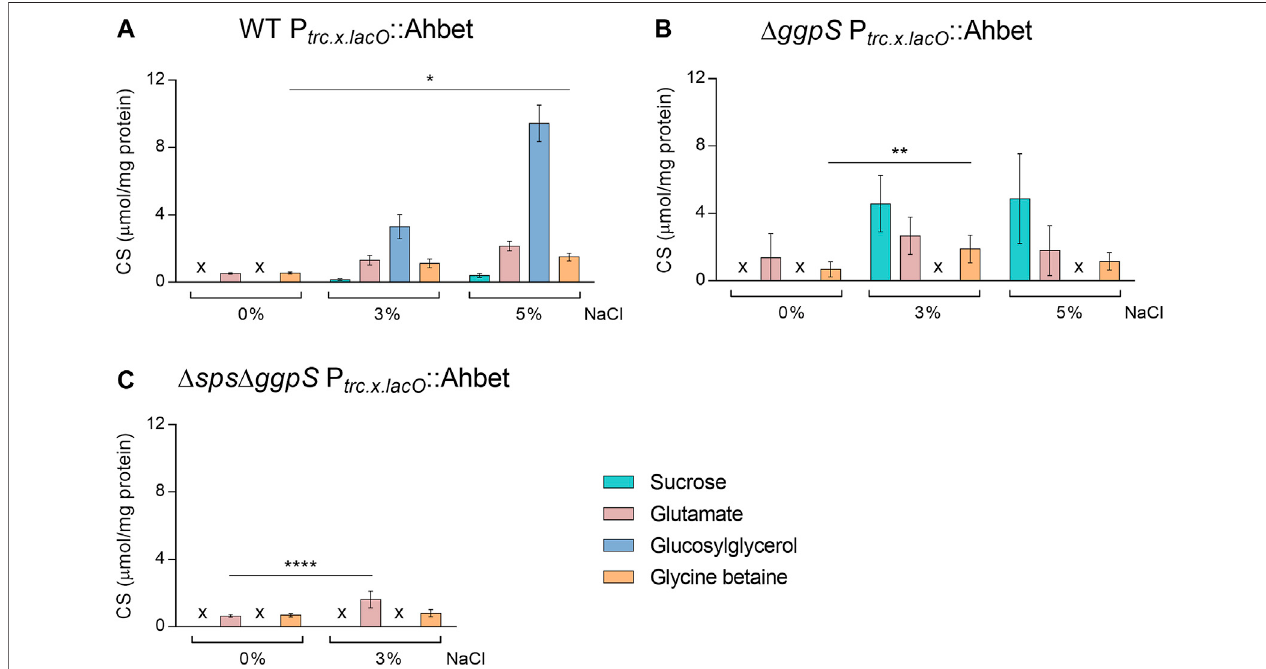
FIGURE 8 | Production of glycine betaine (GB) and native compatible solutes in different Synechocystis strains harboring the GB device: WT (wild-type) P trc.x.lacO :: Ahbet (A) , Δ ggpS P trc.x.lacO ::Ahbet (B) ,and Δ sps Δ ggpS P trc.x.lacO ::Ahbet (C) .CulturesweregrowninBG11orBG11supplementedwith3%or5%(wt/vol)NaCl,at30 ° C with orbital shaking (150 rpm) under a 12 h light (25 μ E/m 2 /s)/12 h dark regimen; and cells were harvested 4 days after inoculation (initial OD 730 ≈ 0.5). Compatible solutes were quanti fi ed by H-NMR and the results were normalized per mg of protein. x — not detected. Error bars correspond to standard deviations from three biological replicates. Statistical analysis was performed using two-way ANOVA. Statistically signi fi cant differences are identi fi ed: **** ( p ≤ 0.0001), ** ( p ≤ 0.01), and * ( p ≤